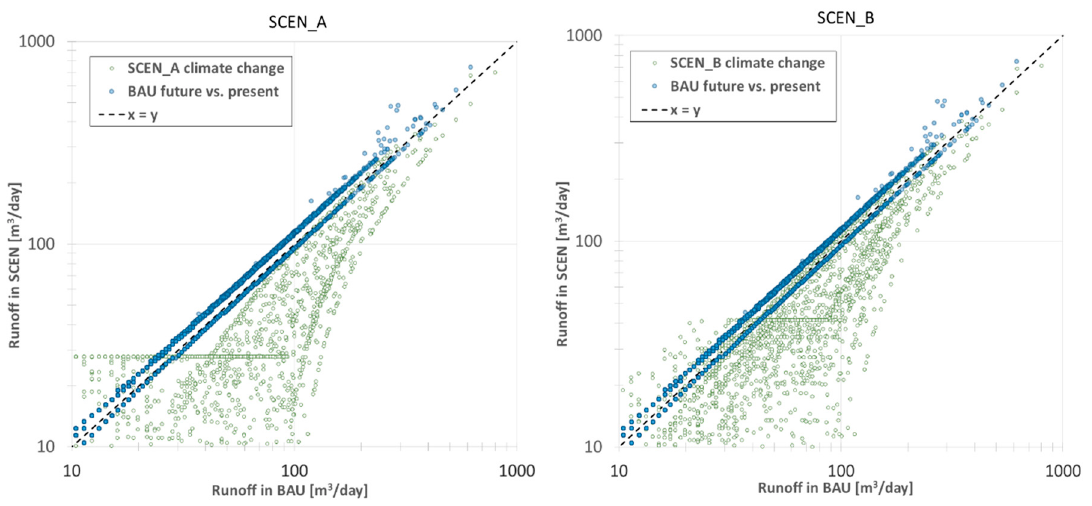
Figure 11. Event-based runoff reduction for a future reality and for both design options.